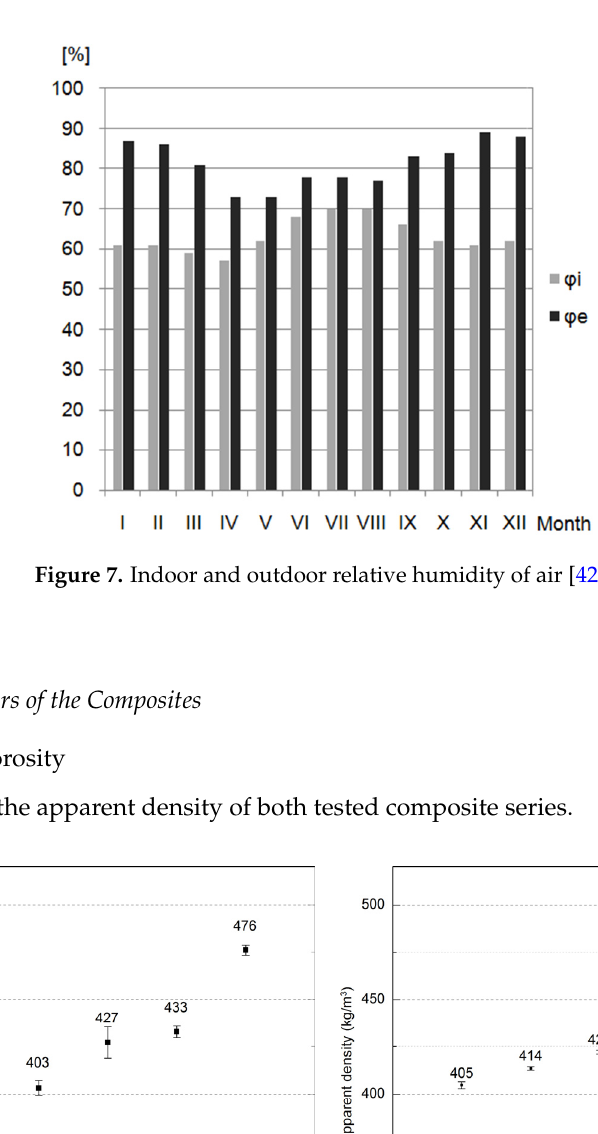
Figure 6. Indoor and outdoor temperature of the air [42].